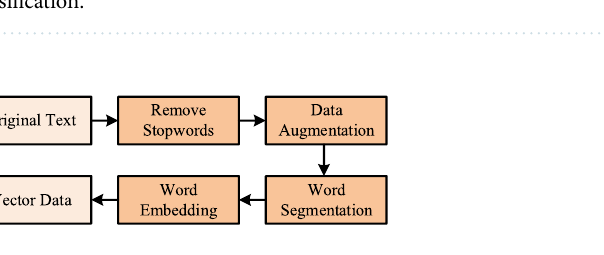
Figure 2. Data pre-processing and data enhancement procedure.